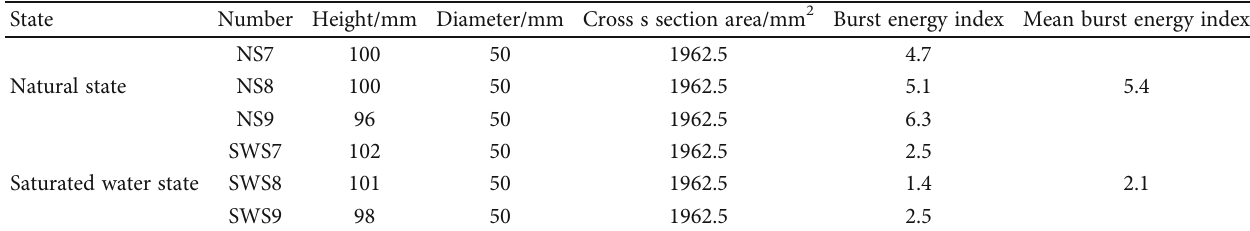
ff erent E ) under di